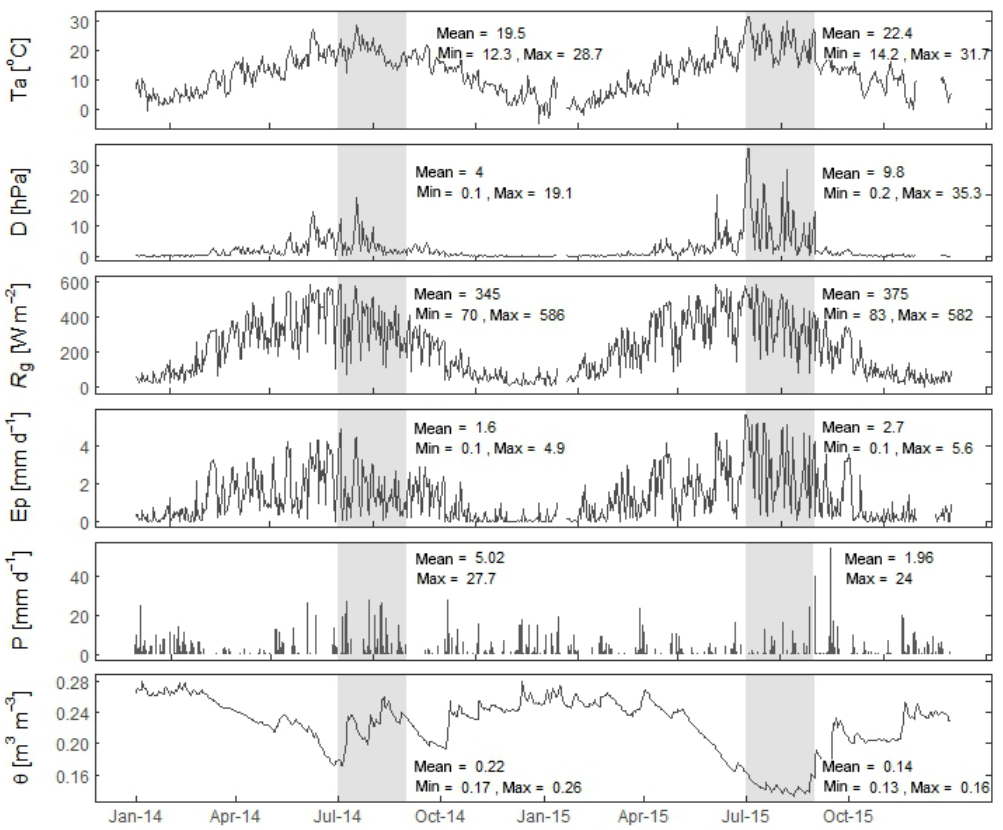
Figure 2. Meteorological conditions in 2014 and 2015. Daily average temperature ( T a ), vapour pressure deficit ( D ), global radiation ( R g ), potential evaporation ( E p ), precipitation ( P ), and soil moisture content ( θ ). The min, mean, and max values are calculated for July and August in both years, indicated by the grey box.